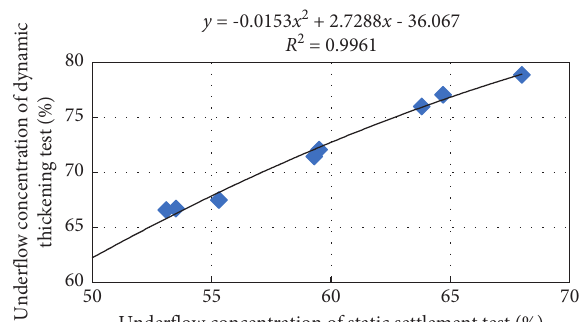
Figure 8: The relation between underflow concentration of static settlement test and underflow concentration of dynamic thickening test when overflow solid content is at 240ppm. Table 5: The relation between particle size and underflow concentration. The relation between median particle size of tailings d50 and underflow concentration of static settlement test C